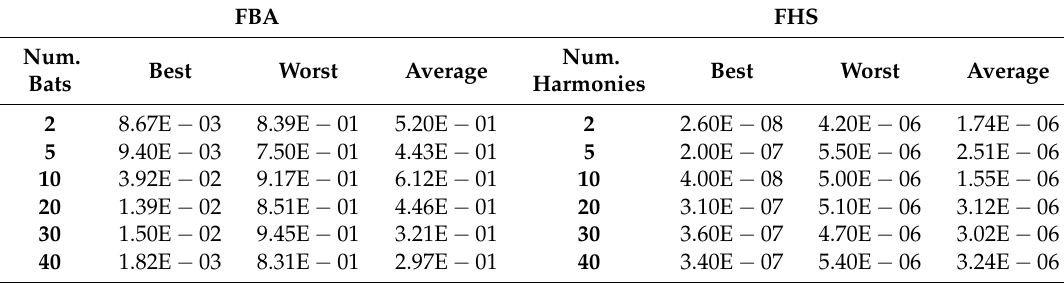
Table 18. Experiment results for the function sum squared with FBA and FHS algorithms. FBA FHS